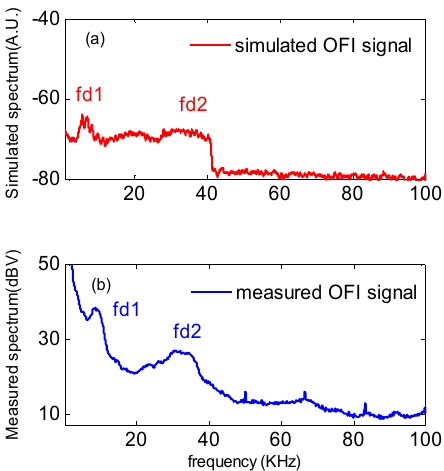
Figure 5. OFI frequency spectrum with a flow rate of 10 µL/min. ( a ) Simulation; ( b )